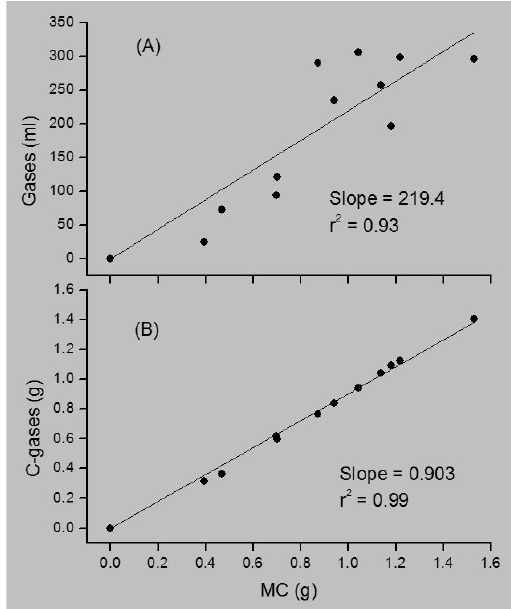
Figure 1. Relation among mineralized carbon (MC) and C-gases (A), and accumulated volume of gases